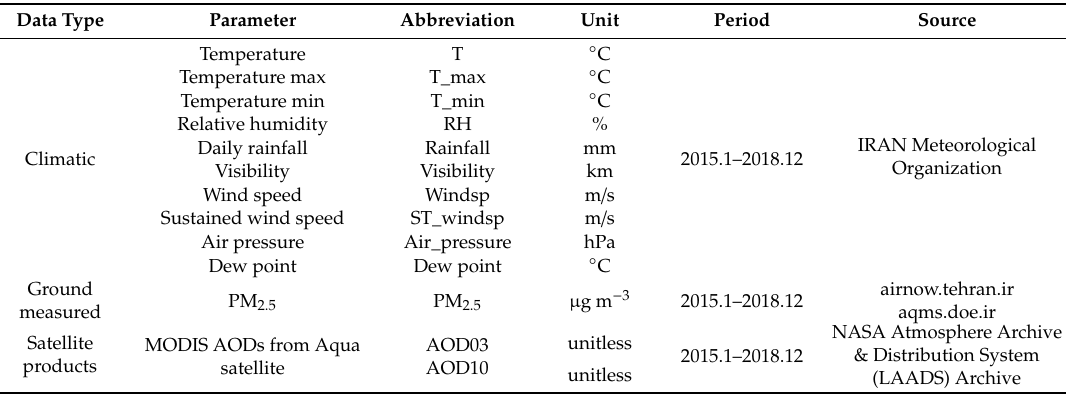
Table 1. List of data and study